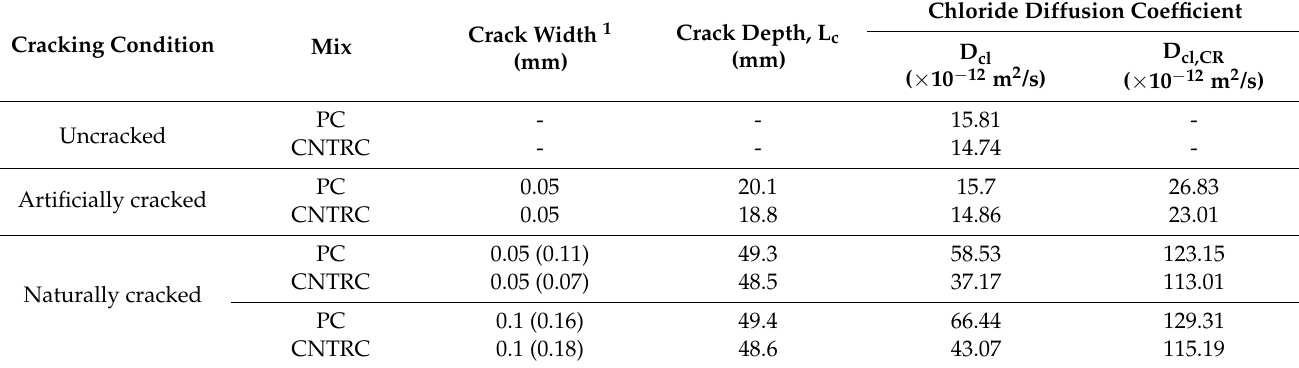
Table 7. Chloride penetration resistance for concrete under different cracking conditions.